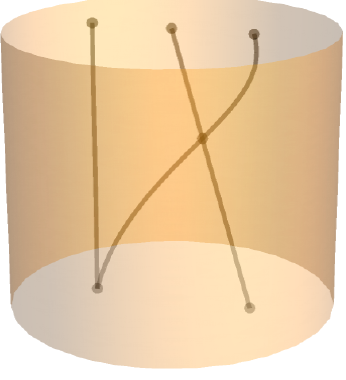
Figure 8. A singular 3-strand